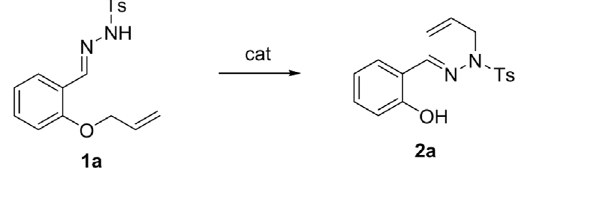
Entry Catalysts